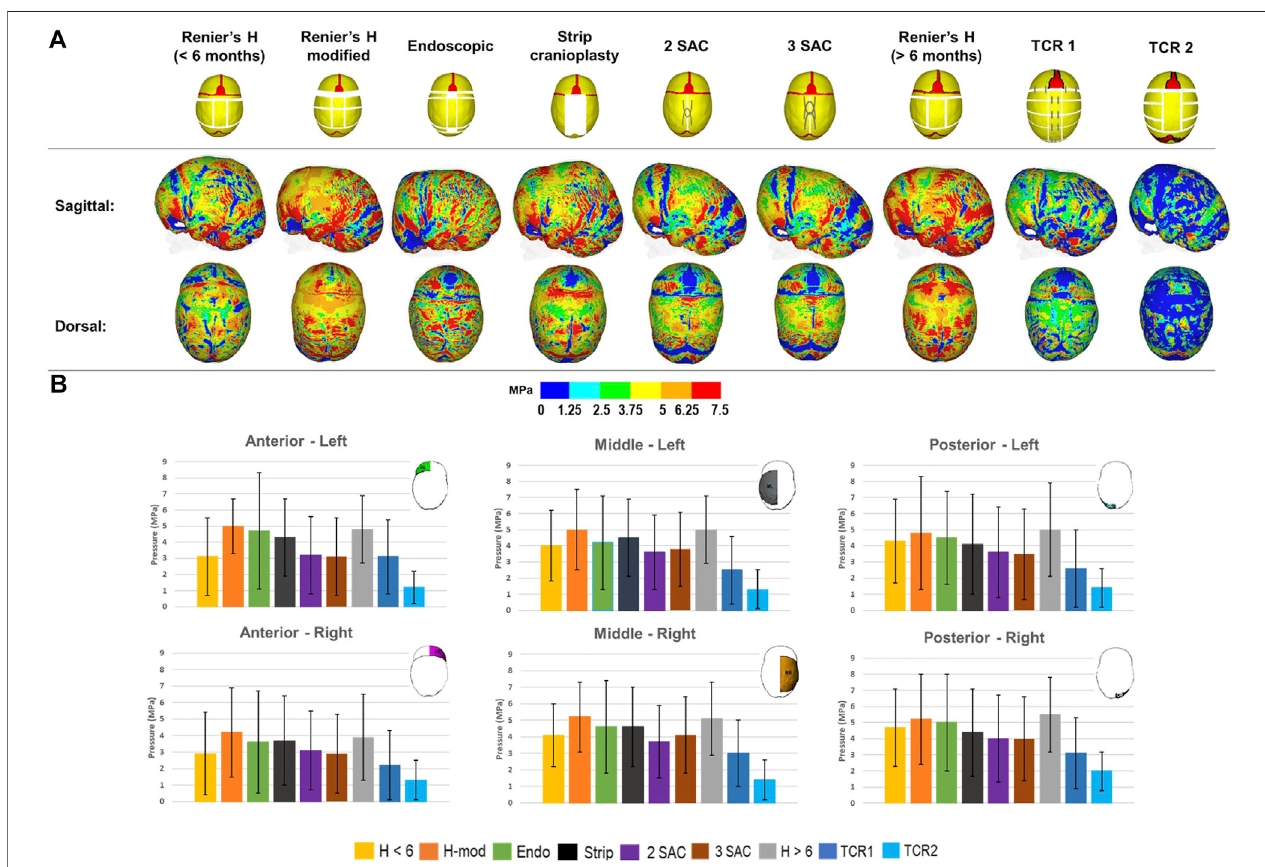
FIGURE 4 | The predicted contact pressure captured across the brain surface for all replicated techniques at 76 months (A) . Contact pressure was quanti fi ed across different regions of the ICV for each replicated technique with standard deviations corresponding to the nodal distribution across the highlighted regions (B) . All results were recorded at 76 months of